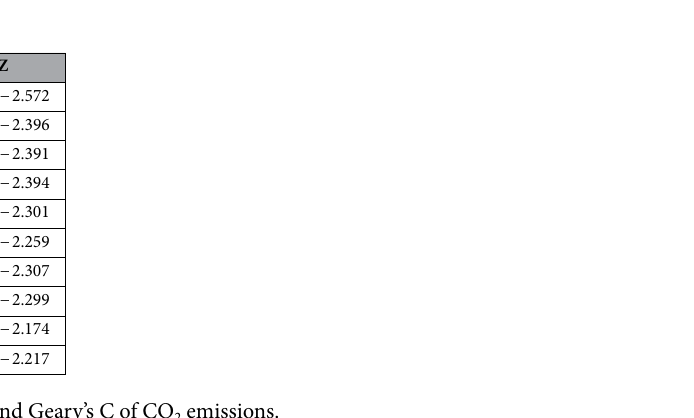
Table 7. The Global Moran ′ s I and Geary’s C of CO 2 emissions.